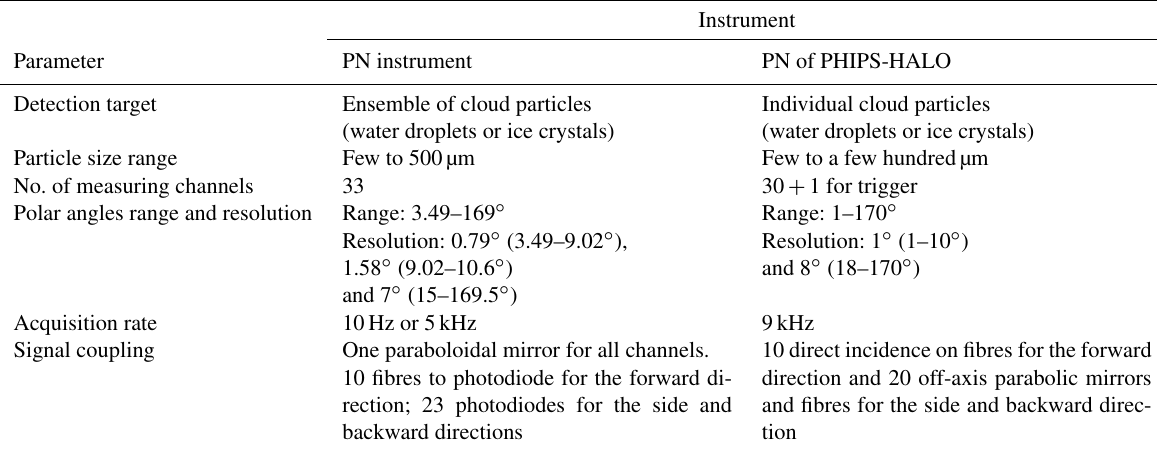
Table 1. The specifications of the PN component of PHIPS-HALO compared to those of the PN instrument.